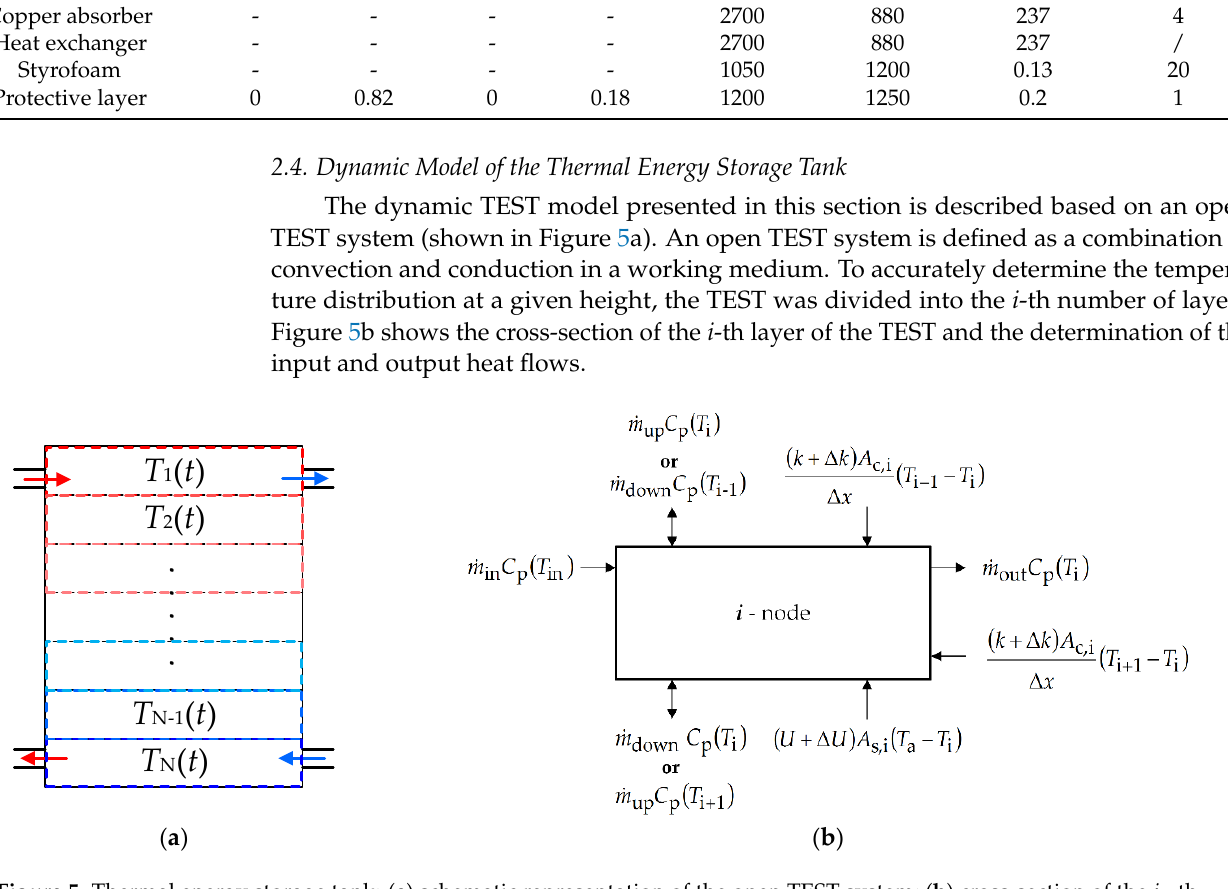
Figure 5. Thermal energy storage tank: ( a ) schematic representation of the open TEST system; ( b ) cross-section of the i − th layer of the TEST (summarized by [63]).